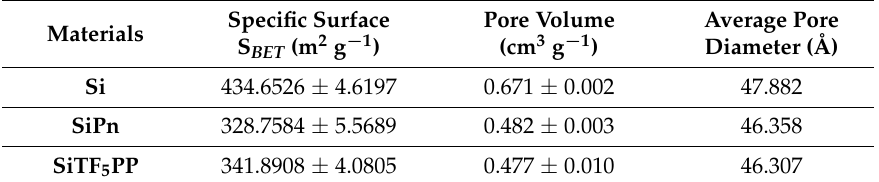
Figure 3. Nitrogen adsorption-desorption isotherm at 77 K plots of SiPn ( A ) and SiTF 5 PP ( B ). Inset is given the respective BJH pore size distribution curves. Table 1. Physical properties of silica-based Table 1. Physical properties of silica-based materials.